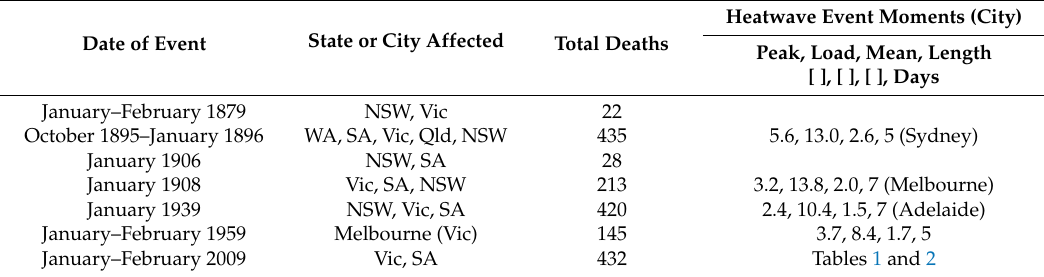
Table 4. Heat Total Deaths for significant heat events in Australia, 1844–2011 [3] (p. 41) by State (WA, Western Australia; SA, South Australia; Vic, Victoria; NSW, New South Wales; Qld, Queensland) or City affected and heatwave event moments for affected city.